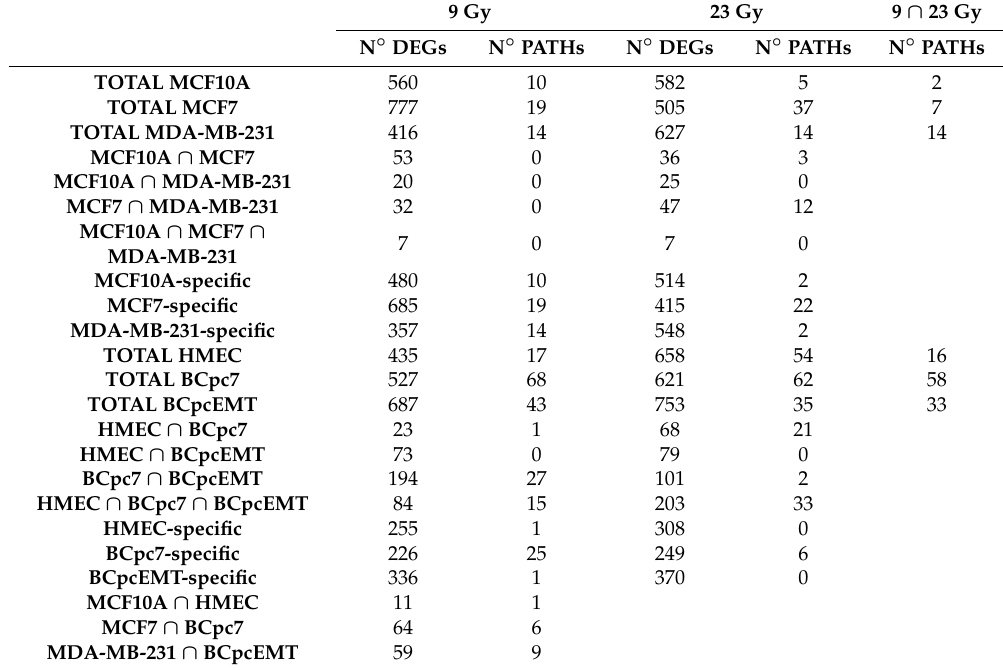
Table 1. Results of Venn diagram analysis comparing differentially expressed genes (DEGs) and enriched pathways (PATHs) in the different experimental conditions: human immortalized cell lines (MCF10A, MCF7, and MDA-MB-231) and three primary cell cultures (HMEC, BCpc7, and BCpcEMT) after irradiation with 9 or 23